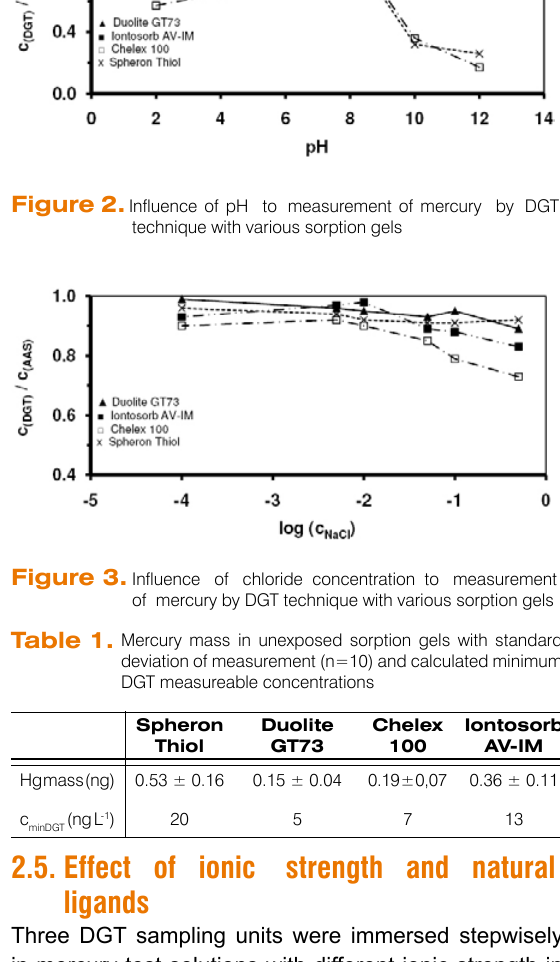
Hg mass (ng) 0.53 ±